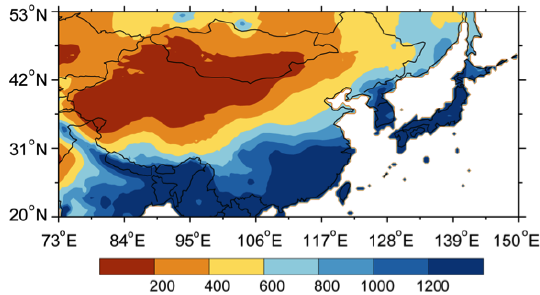
Figure 1. Spatial distribution of annual mean precipitation from 1961 to 1990 (mmyear − 1 )